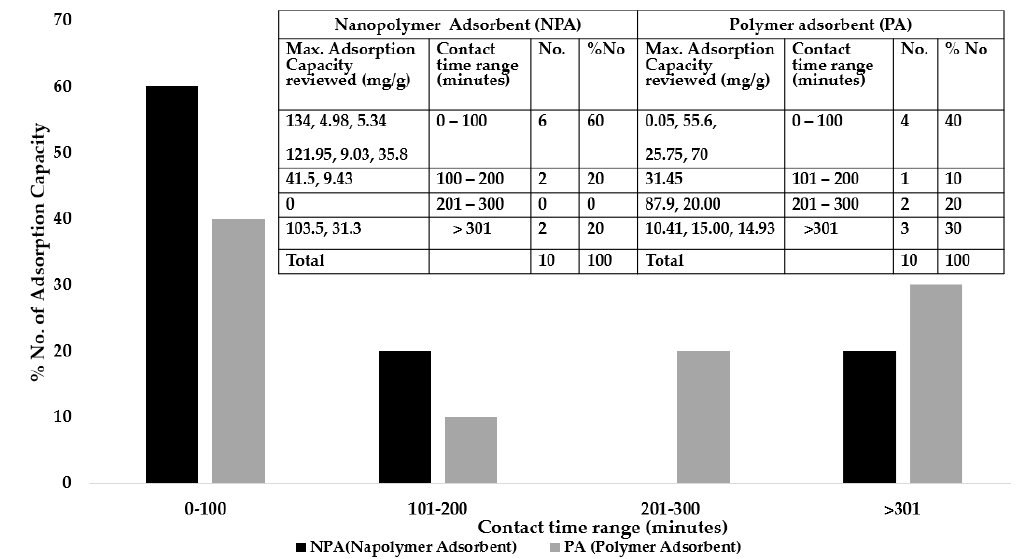
Figure 6. Contact time with maximum adsorption capacities for polymer and nanopolymer adsorbents.